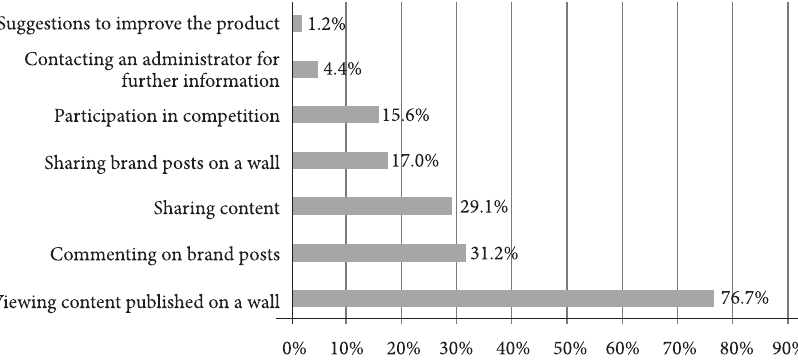
Figure 4. Consumer engagement towards their favourite brand on